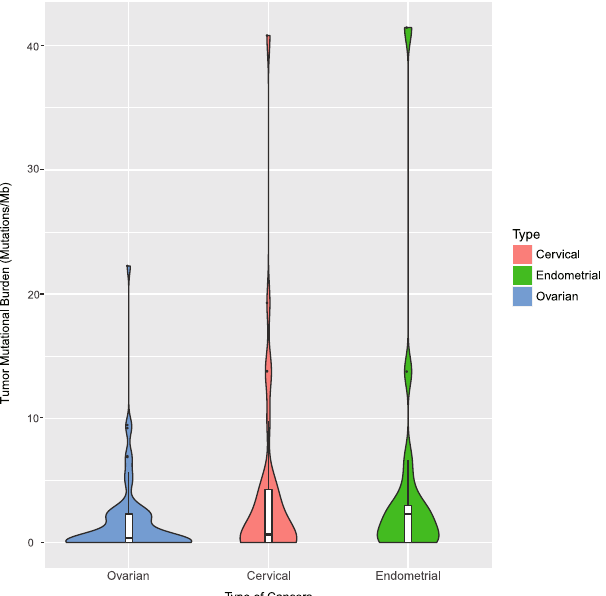
Figure 2. TMB levels of gynecologic